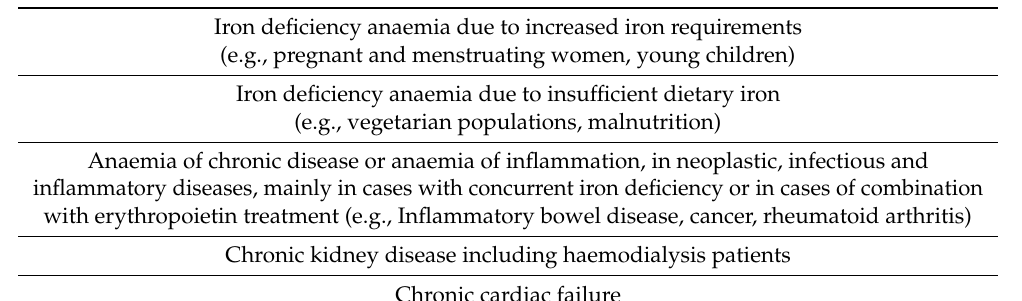
Table 2. Examples of anaemias treated with iron